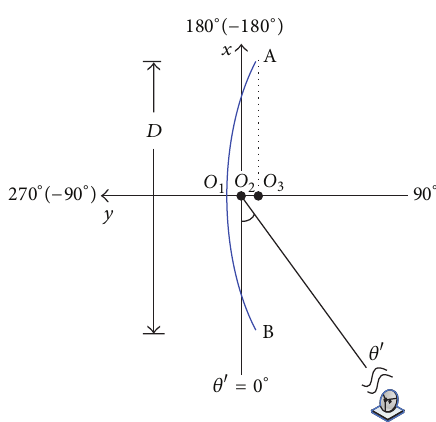
Figure 3: PRA geometry for GO, PO and